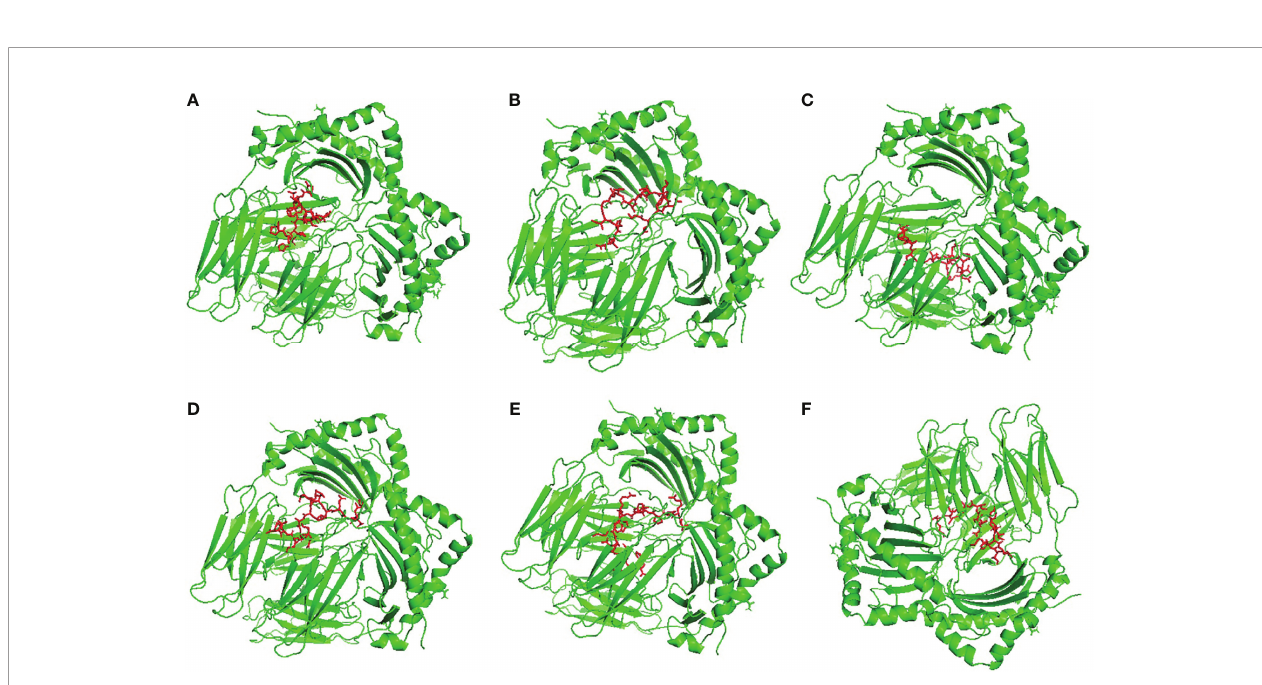
FIGURE 3 | Structural positions of MHC-II epitopes (red color) in 3-dimensional structure of HLA-DRB1*04:01 (green color), structures (A – F) are for epitopes number 1,2,3,4,5 and 6 respectively from Table 4